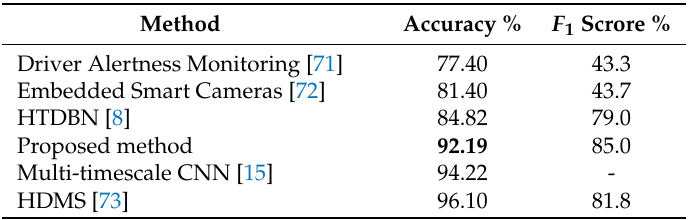
Table 3. Comparison of 3D ConvNets and baseline solution on scenarios in the drowsy-driver-detection dataset.